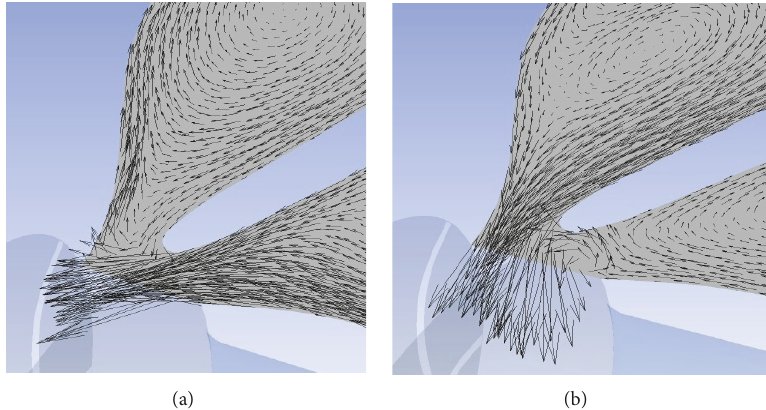
Figure 16: Velocity vectors at a volute cross section for (a) partial shroud and (b) partial hub